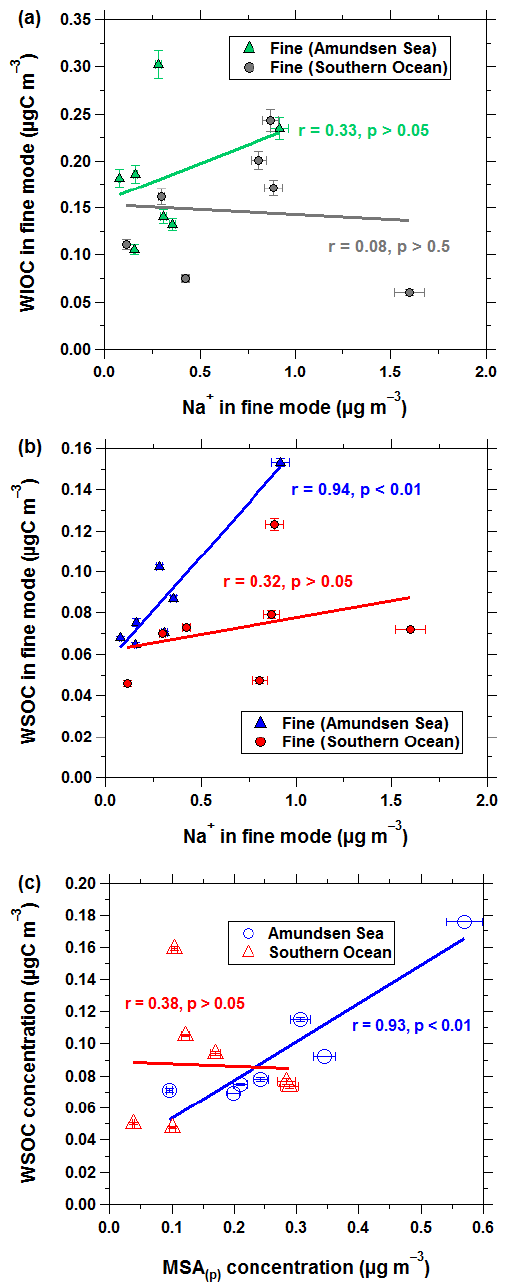
Figure 8. Relationships of WIOC (a) and WSOC (b) with Na + in fine modes over the Southern Ocean (solid triangles) and the Amundsen Sea (solid circles). (c) Relationships between WSOC and MSA ( p ) concentrations over the Southern Ocean (open trian- gles) and the Amundsen Sea (open